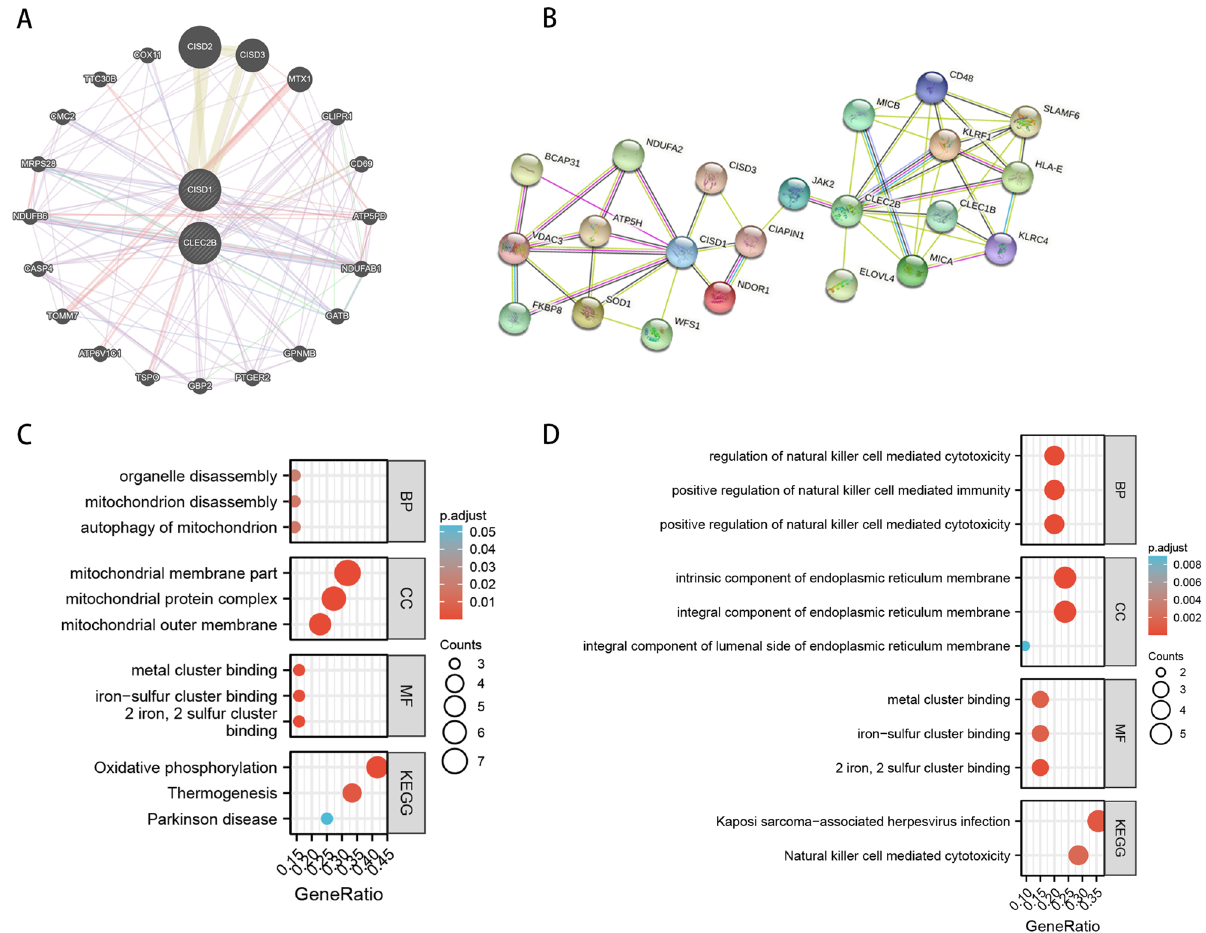
Figure 6. Functional correlation analysis of CLEC2B and CISD1. ( A ) PPI network from GeneMANIA after searching with CLEC2B and CISD1. ( B ) PPI network form STRING after searching with CLEC2B and CISD1. GO/KEGG enrichment analysis of gene lists from GeneMANIA ( C ) and STRING ( D ). In the enrichment result, FDR < 0.05 is considered to be enriched to a meaningful pathway. BP: The biological process; CC: cellular component; MF: molecular